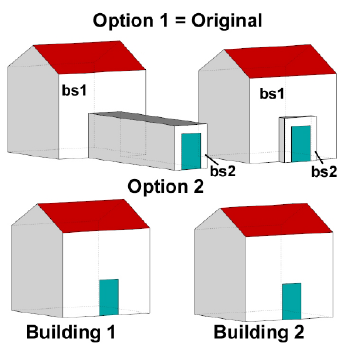
Figure 5. Impact of mapping the polygons to the BoundarySurfaces on the model simplification